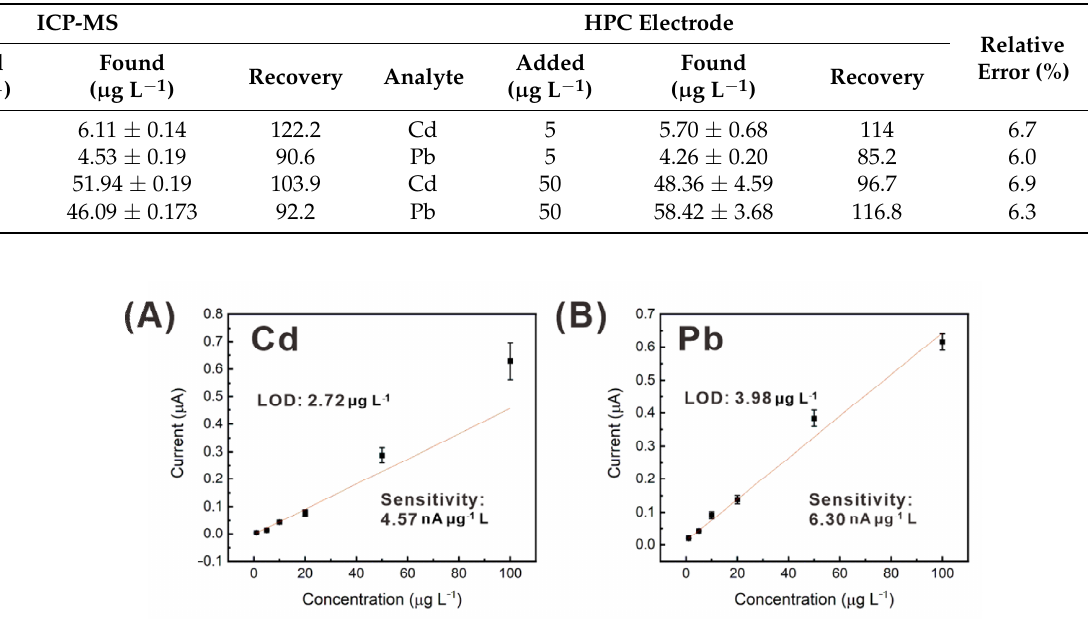
Figure 10. SWASV peak current signals from a real tap-water sample spiked with ( A ) cadmium and ( B ) lead at various concentrations (0, 1, 5, 10, 20, 50, and 100 µ g L − 1 ), obtained by using the HPC-based heavy metal